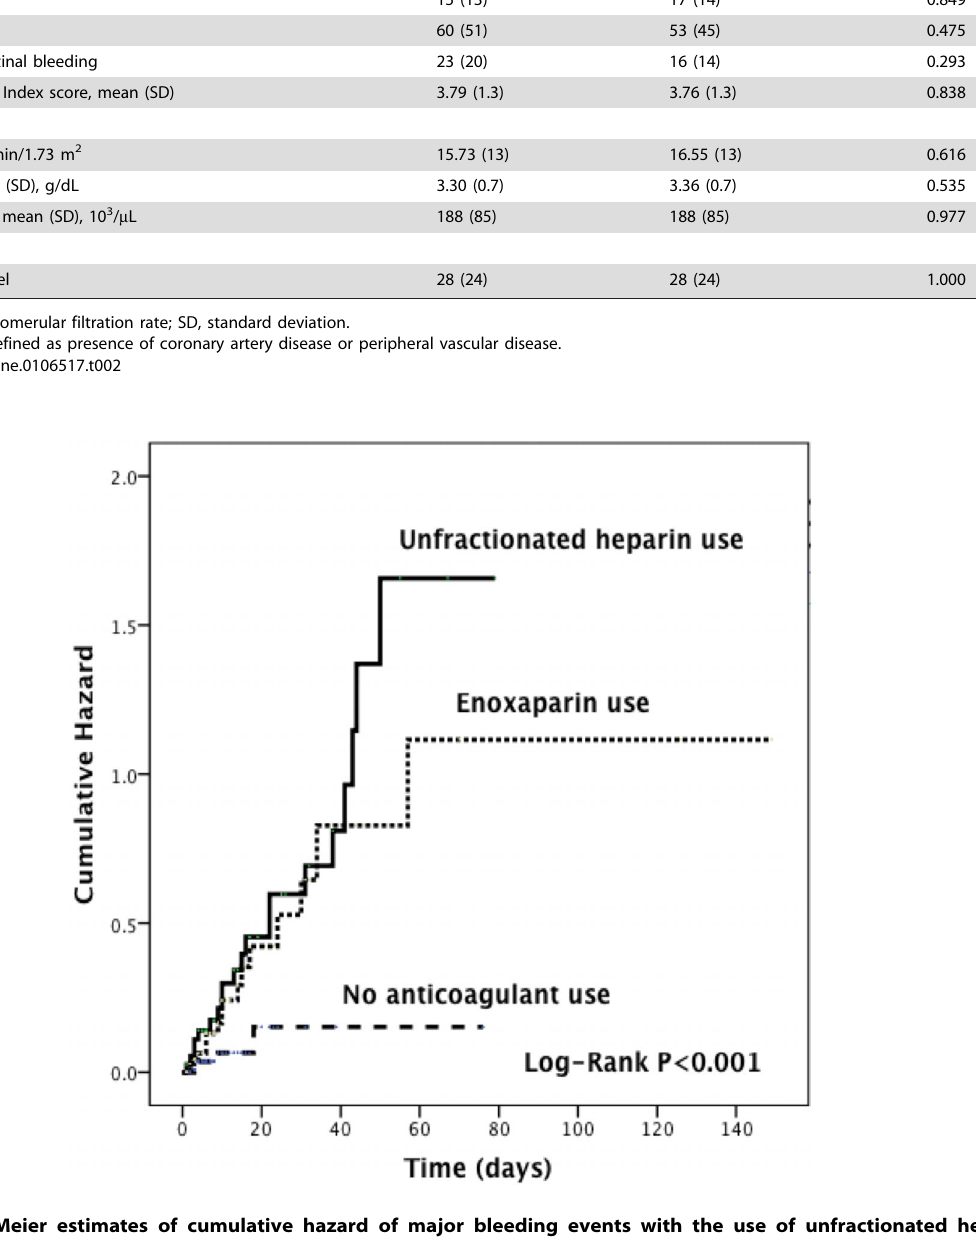
No. (%) of Participants